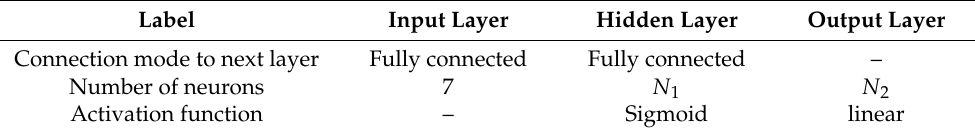
Table 4. Main parameters of DINN. Label Input Layer Connection mode to next